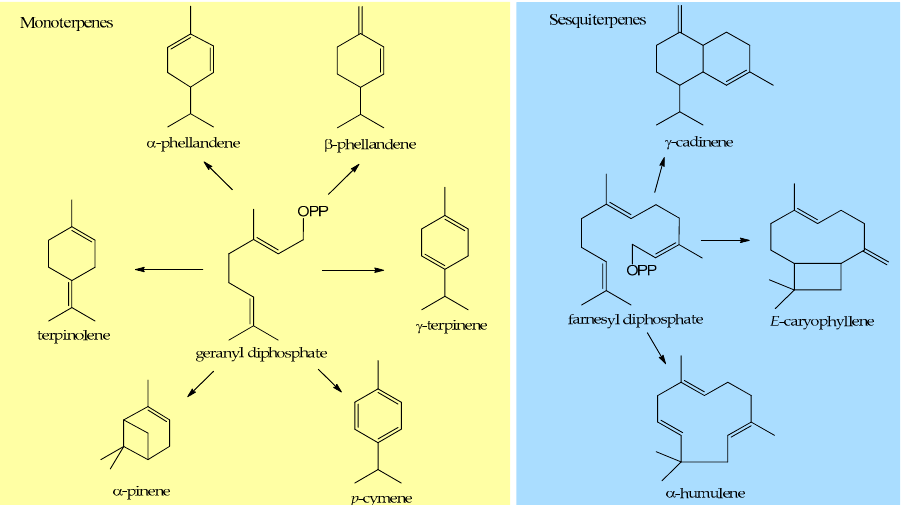
Figure 1. Primary mono- and sesquiterpenes arising from the geranyl and farnesyl diphosphate identified in the essential oils of Myrciaria species leaves. OPP = OPO 2 OPO 3 − 3 .